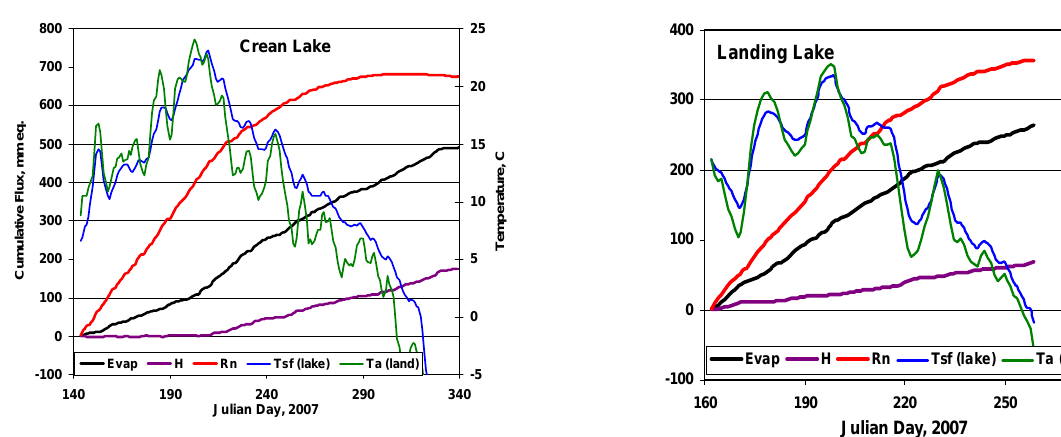
Figure 5. The cumulative evaporation, sensible heat and net radiation for Landing Lake, Fig. 5. The cumulative evaporation, sensible heat and net radia- 2007; showing 5-day average water surface temperature and air temperature over land. tion for Landing Lake, 2007; showing 5-day average water surface temperature and air temperature over